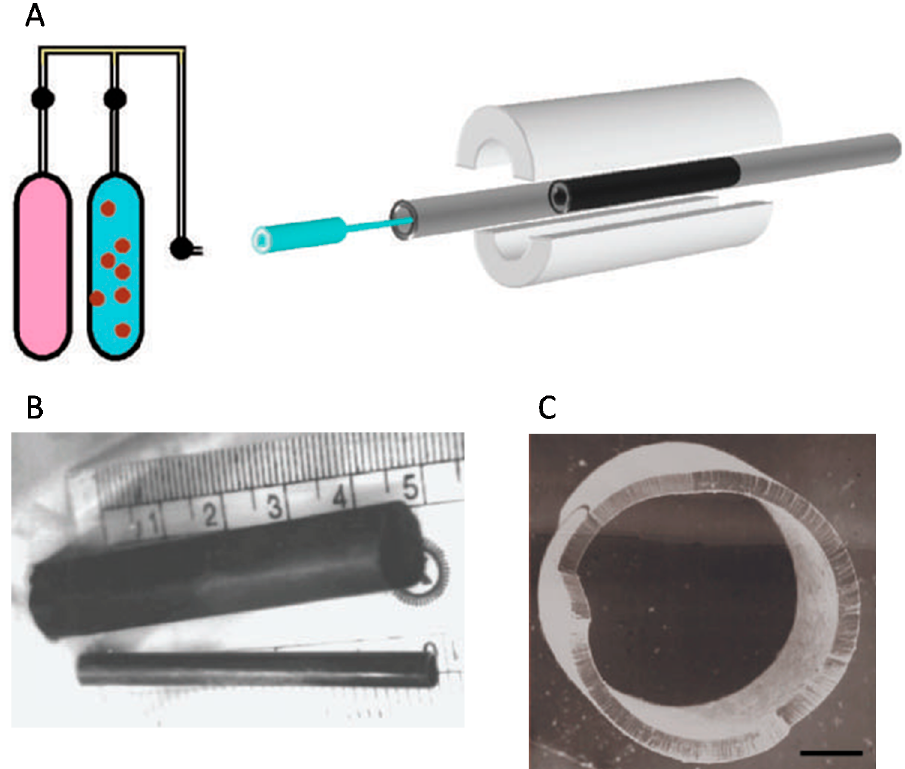
Figure 4. Production of a macro architecture consisting of aligned multi-walled carbon nanotubes (MWNTs), for use in filtration applications. ( A ) Schematic of the spray pyrolysis apparatus used for growing aligned MWNTs. The process consisted of a nozzle attached to a ferrocene/benzene solution supply used for releasing the solution into a quartz tube, mounted inside a temperature-controlled cylindrical furnace. A benzene/ferrocene solution was injected into the quartz tube, using argon as a carrier gas, and the temperature of the furnace then increased to 900 °C; ( B ) Photograph of the bulk nanotube architecture produced by the above method; ( C ) SEM image of the aligned nanotubes with radial symmetry, resulted in a hollow cylindrical structure (scale 1 mm). Reprinted by permission from Macmillan Publishers Ltd from Reference [45]. Copyright Nature Publishing Group 2004.